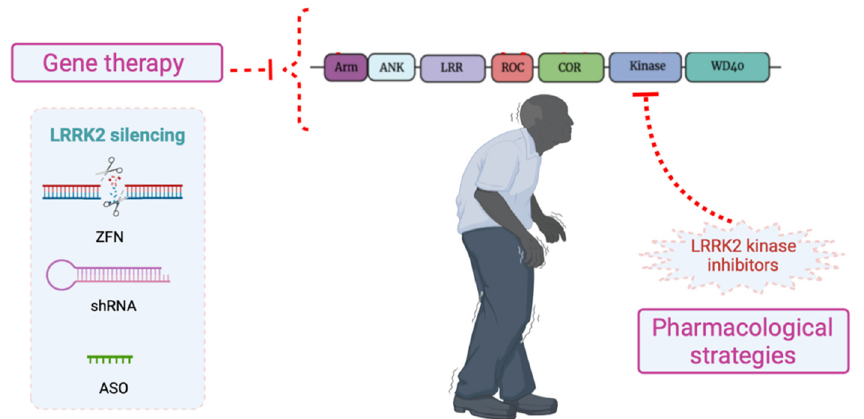
Figure 3. LRRK2 as therapeutic target for PD. Among the therapeutic options to manage LRRK2 activity in PD are included pharmacological strategies that involved the use of LRRK2 kinase inhibitors and gene therapy approaches to knock-down LRRK2 expression by zinc-finger nucleases (ZFN), short-hairpin RNA (shRNA) molecules or antisense oligonucleotides (ASO).